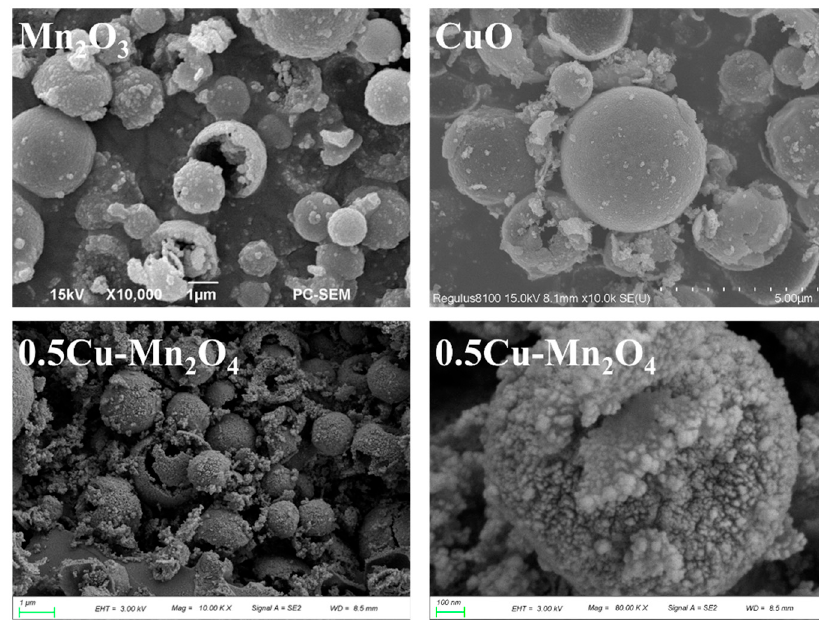
Figure 4. SEM morphologies of each